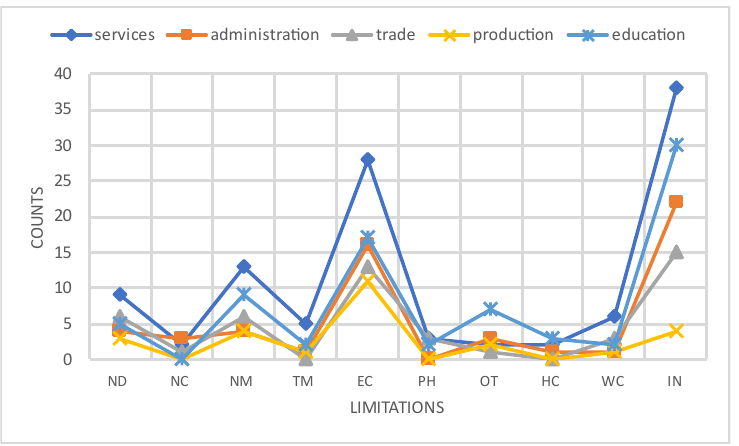
Figure 20. A graph of interactions between limitations in terms of car availability and the respondent’s vocation.